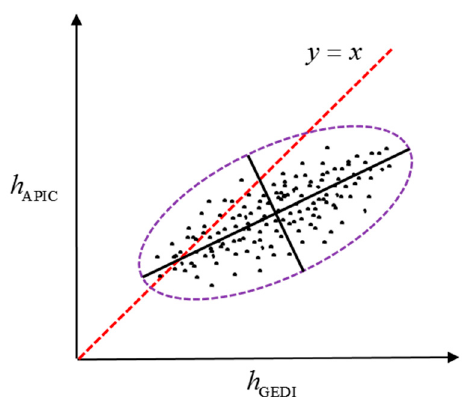
Figure 1. Scattered points cloud determined by the estimated forest height and the Global Ecosystem Dynamics Investigation (GEDI) canopy